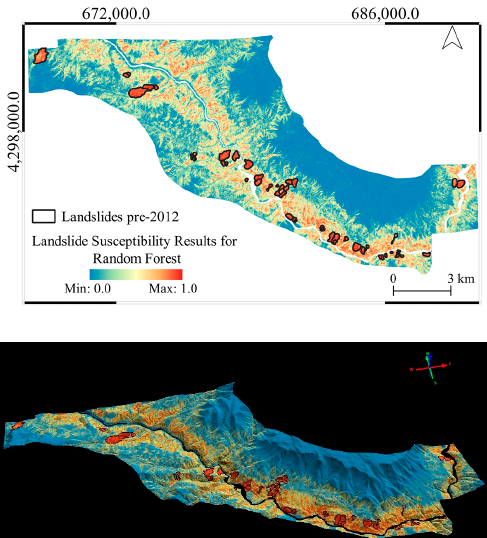
Figure 12. The landslide susceptibility map produced with the RF method in 2D (above) and 3D (below) visualization.